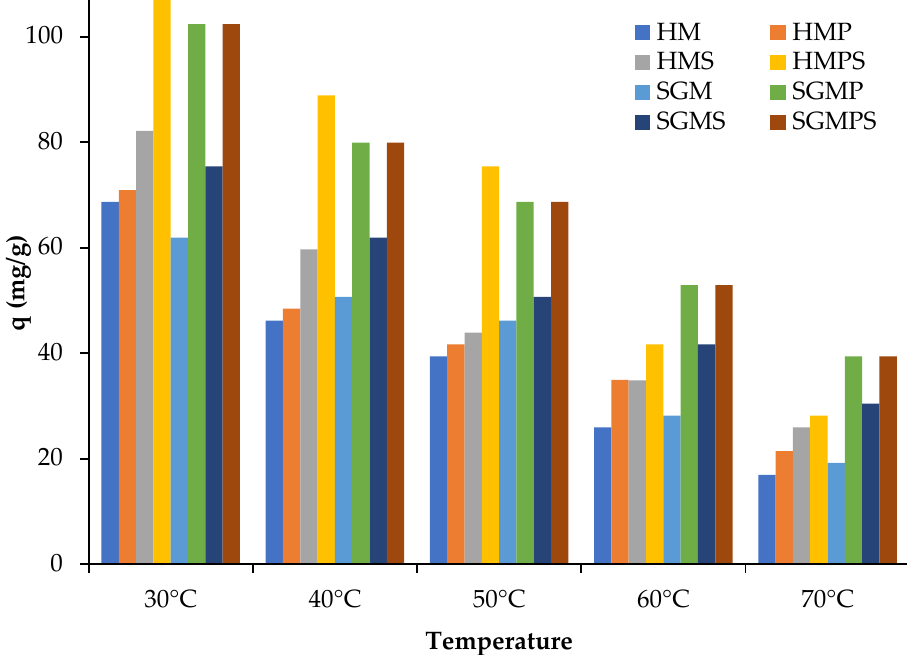
Figure 5. Effect of temperature on direct violet 51 adsorption by various materials.